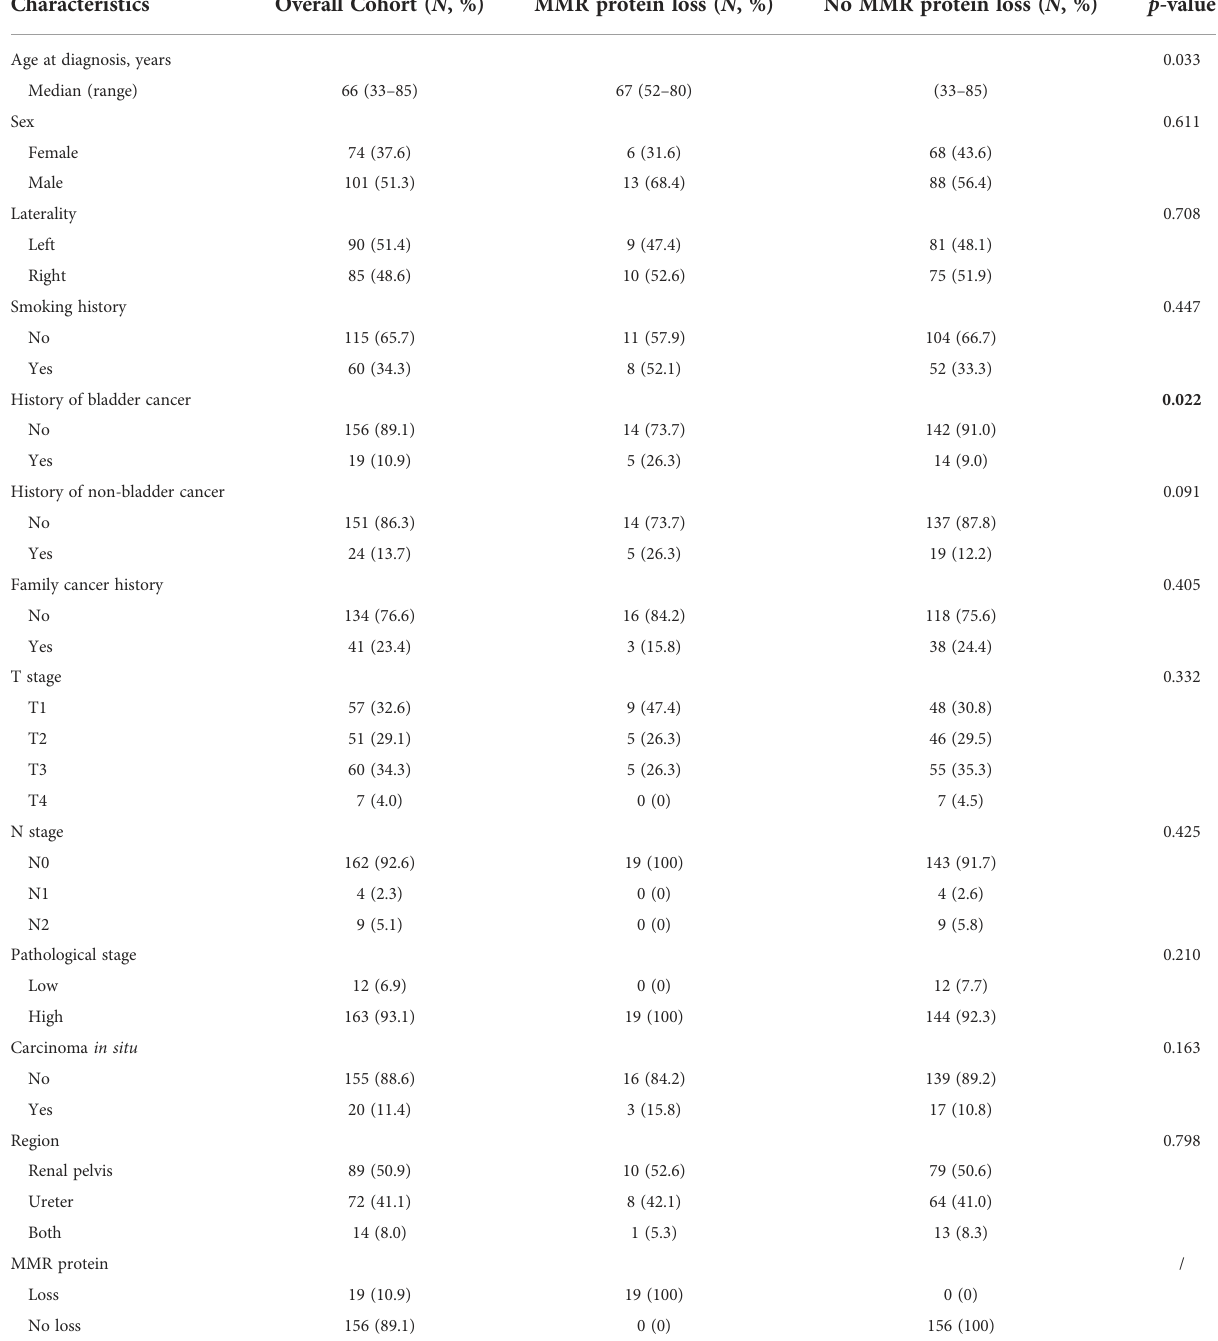
TABLE 1 Baseline characteristics of the study cohort ( N =